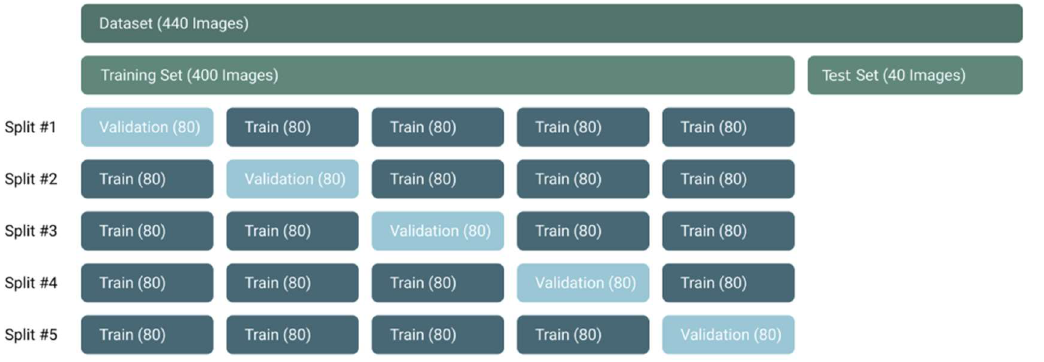
Figure 5. Five-fold cross-validation.